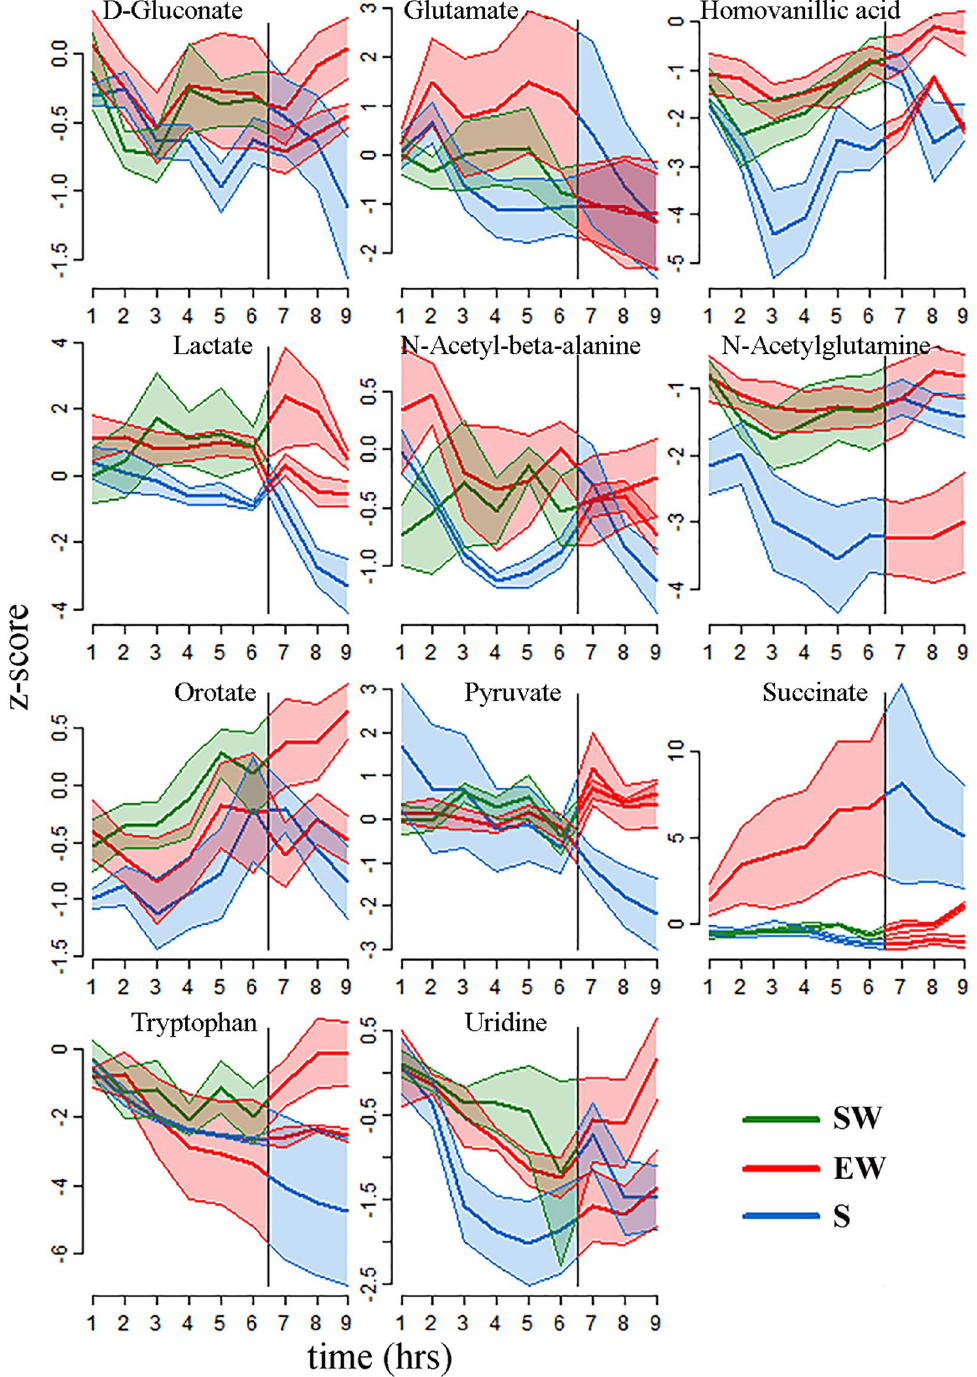
Figure 3. Time course of z-score changes for the 11 metabolites with significant and consistent differences between behavioral states in mPFC (mean ± sem). In each plot the vertical line indicates a behavioral state transition at hour 6 (e.g, from S6 to EW3). Typically, the levels of these metabolites were decreasing during sleep, and either increasing or constant during the two wakefulness conditions. Abbreviations: mPRF (medial prefrontal cortex); SW, spontaneous wake; EW enforced wake; S, spontaneous